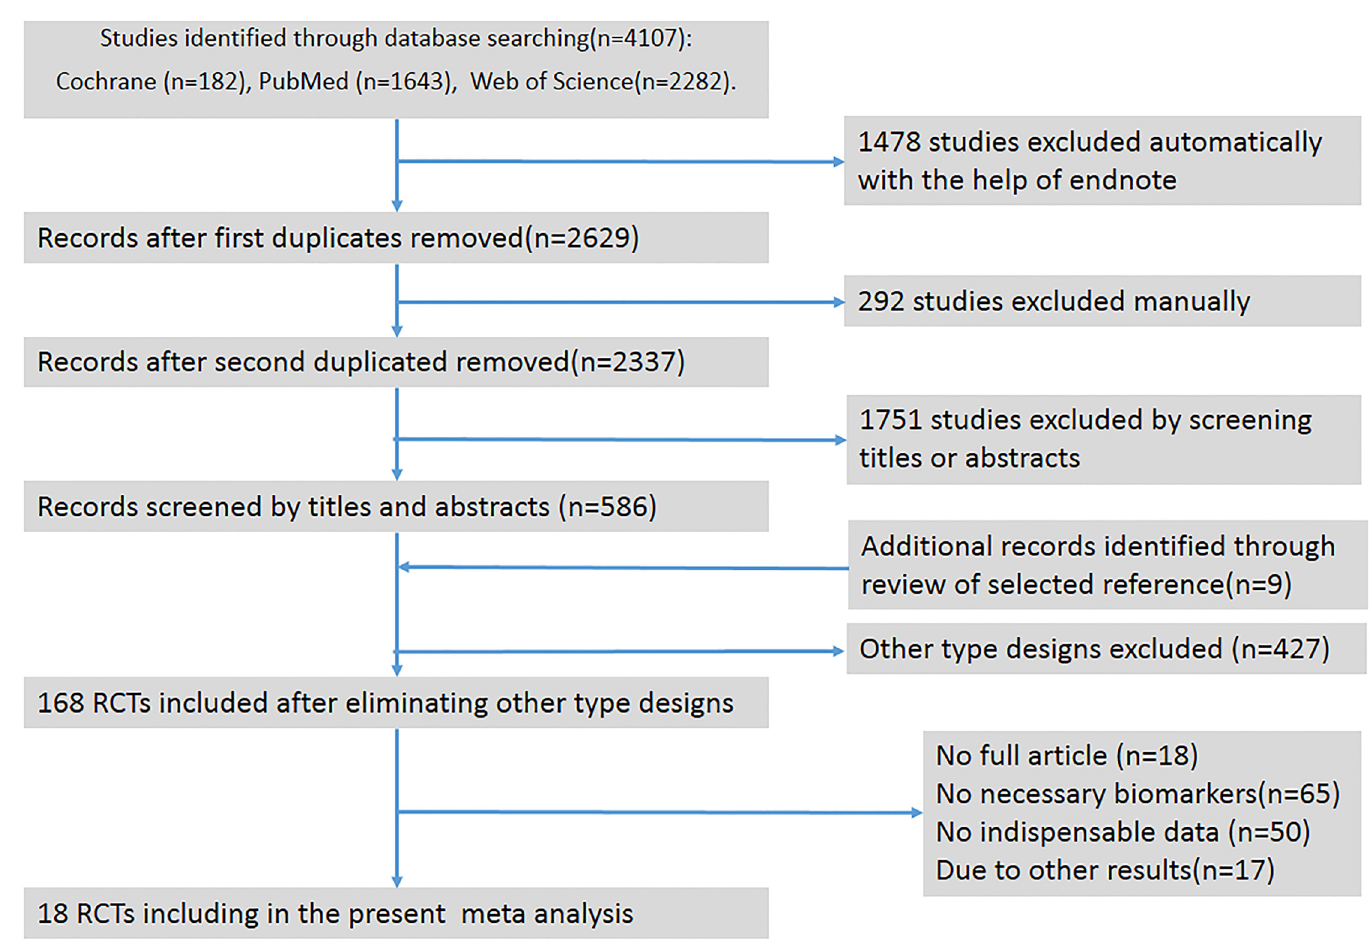
Fig 1. Flow diagram of studies evaluated in the review. RCT, randomized controlled